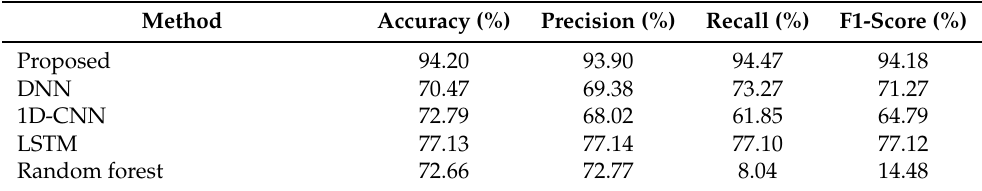
Table 9. Performance comparison with other